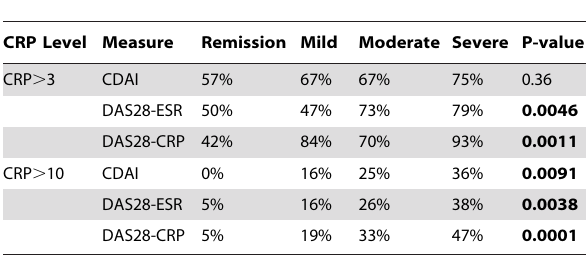
Table 2. Prevalence of CRP . 3 mg/L and . 10 mg/L in patients categorized by level of disease activity.